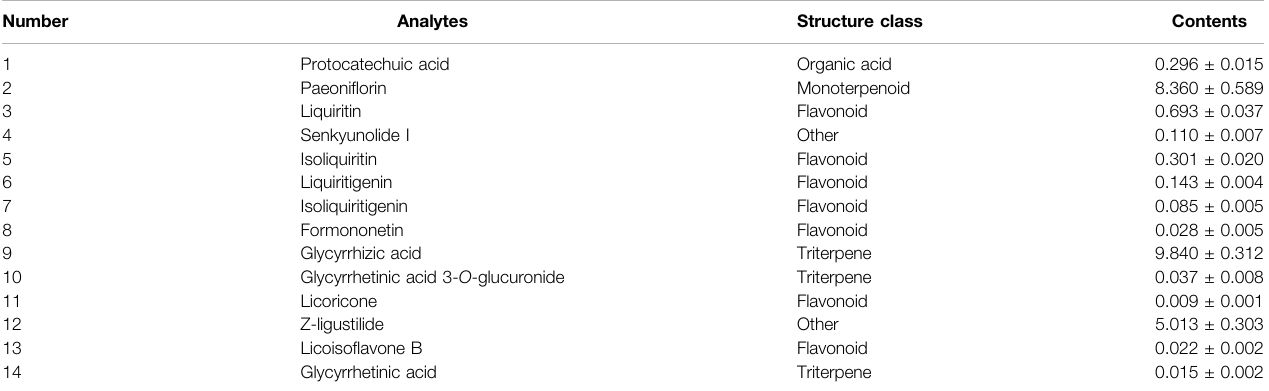
TABLE 1 | The contents of fourteen quality marker components of HHXYT (batch number: 190106, mg/g, Mean ± SD, n = 3).